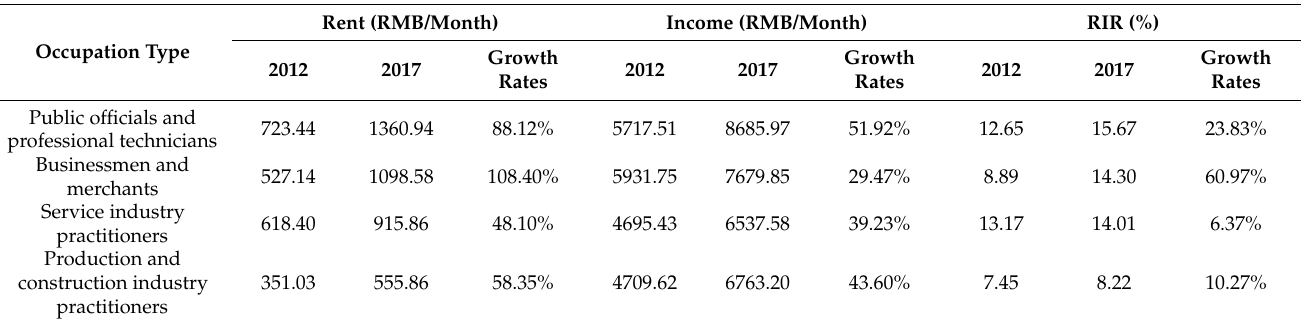
Table 2. Rent, income, and the RIR of groups with different occupational characteristics, 2012 and